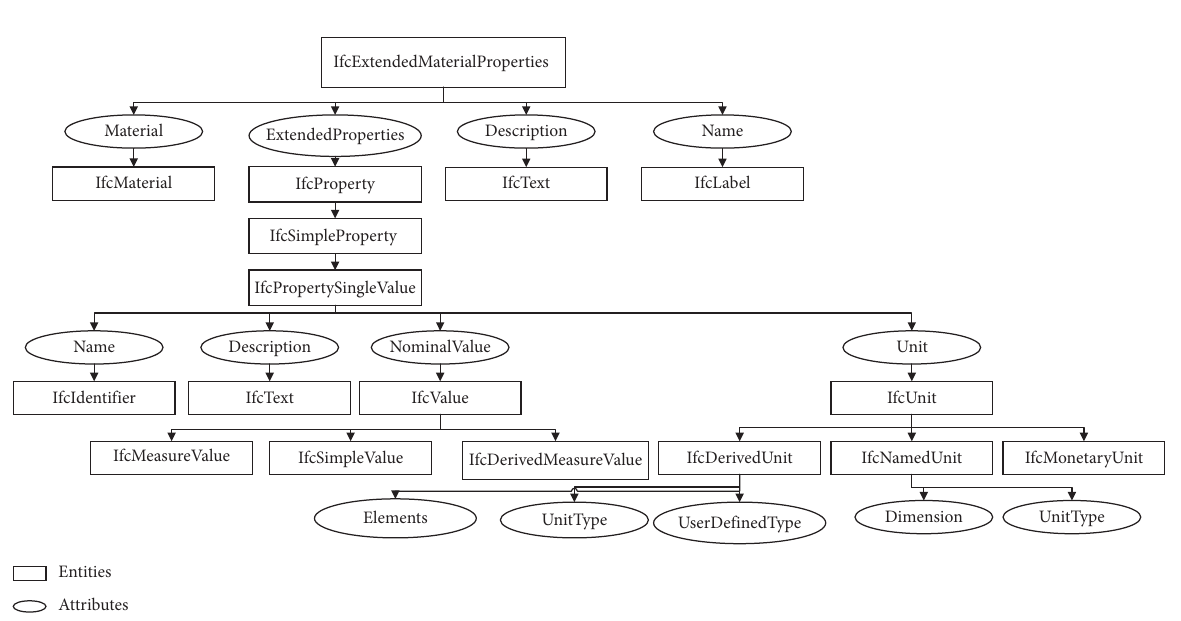
Figure 5: Common material property representation based on IFC schema.